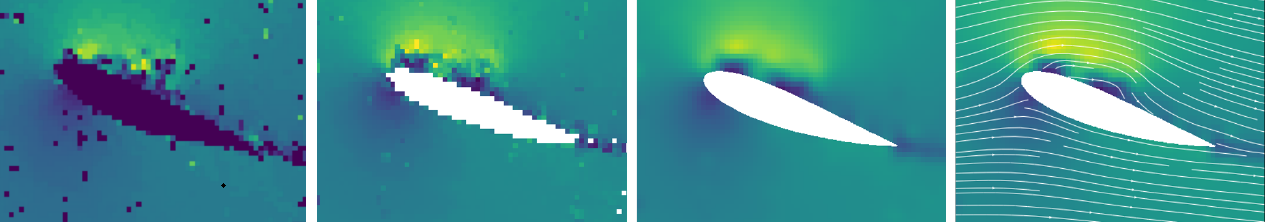
Figure 6. Postprocessing corrections on the vector field: ( far left ) Raw flow field with magnitude of the pixel shift and empty spaces from low correlation ( < 0.3). ( center left ) Resulting field after application of the temporal rolling average with window size 4. ( center right ) final velocity field, after application of a Gaussian filter and calibration. ( far right ) Filtered vector field with streamlines: The velocity is displayed as non-dimensional velocity relative to the average flow speed v / ¯ v